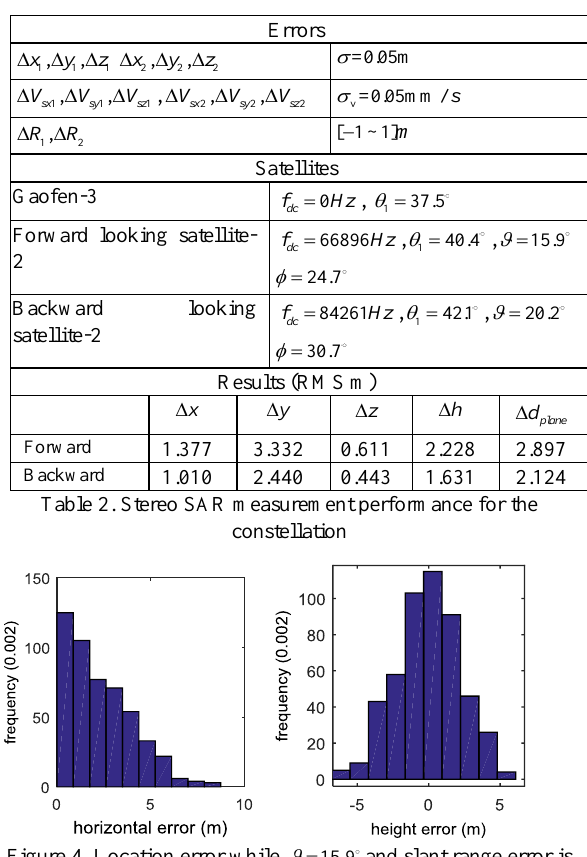
Figure 4. Location error while 15 . 9   and slant range error is